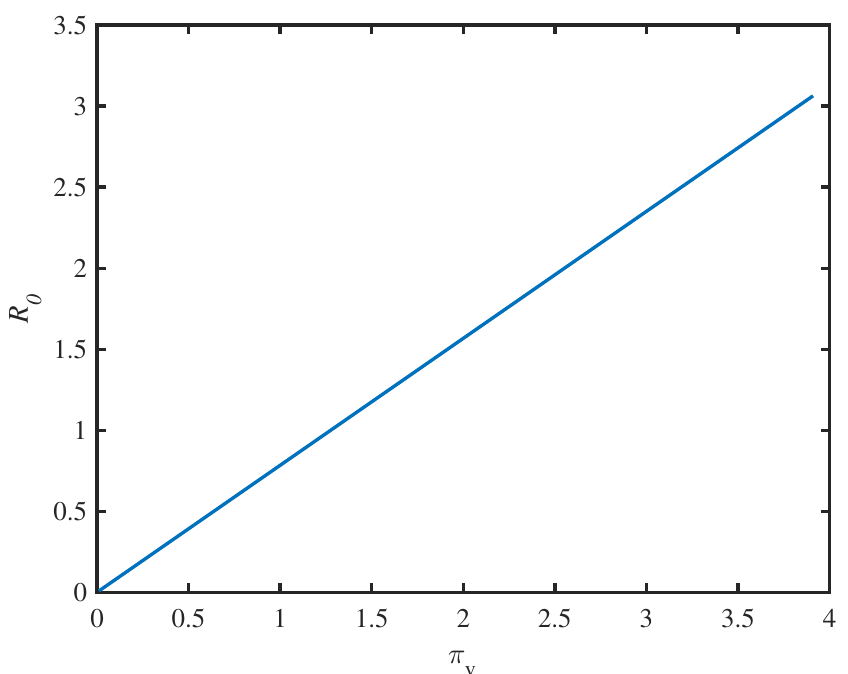
Figure 7. The positive relationship between R 0 and π v